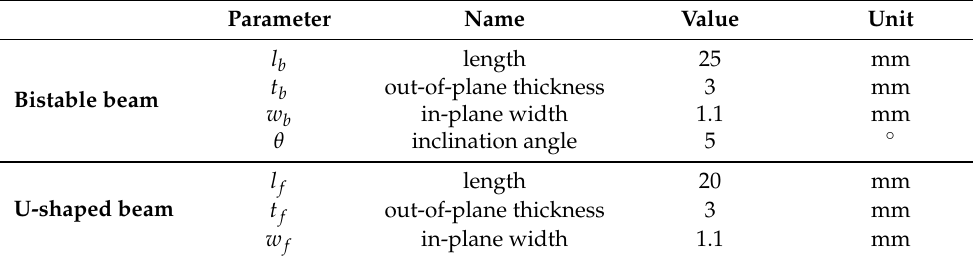
Table 1. Parameters of the preliminary constant force mechanism.